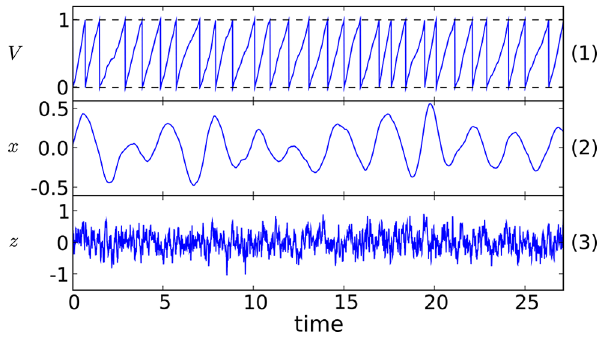
Figure 1. Illustration of the neuron model, showing a calculated membrane voltage trace (upper panel) that yields a spike time whenever a threshold level is reached, and sample trajectories of input narrow-band harmonic noise (middle panel) and broadband short-correlated Ornstein-Uhlenbeck (OU) noise (lower